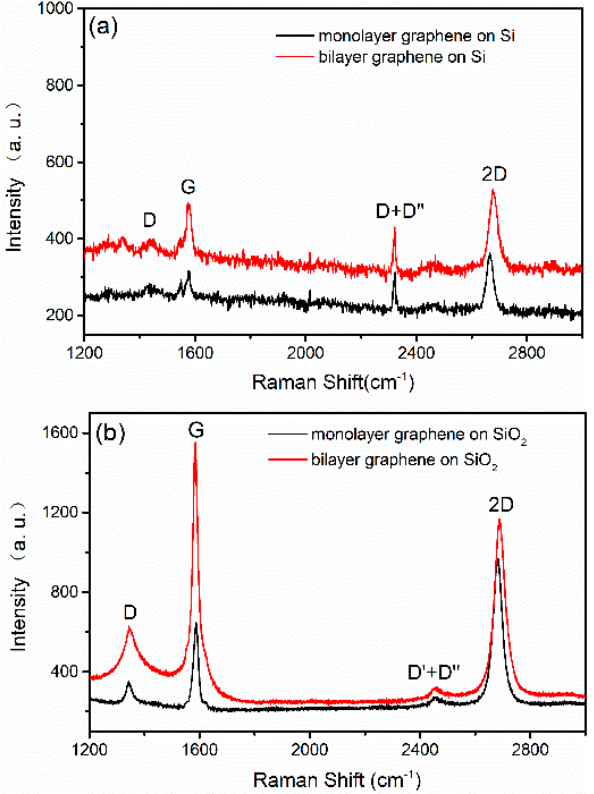
Figure 1. Raman scattering spectra of graphene samples. ( a ) graphene on Si substrate; ( b ) graphene on SiO 2 /Si substrate.